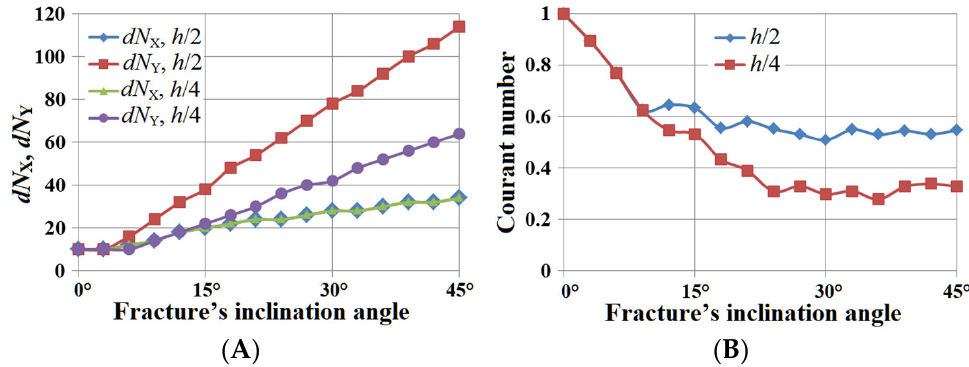
2 h h  and 4 h MIN